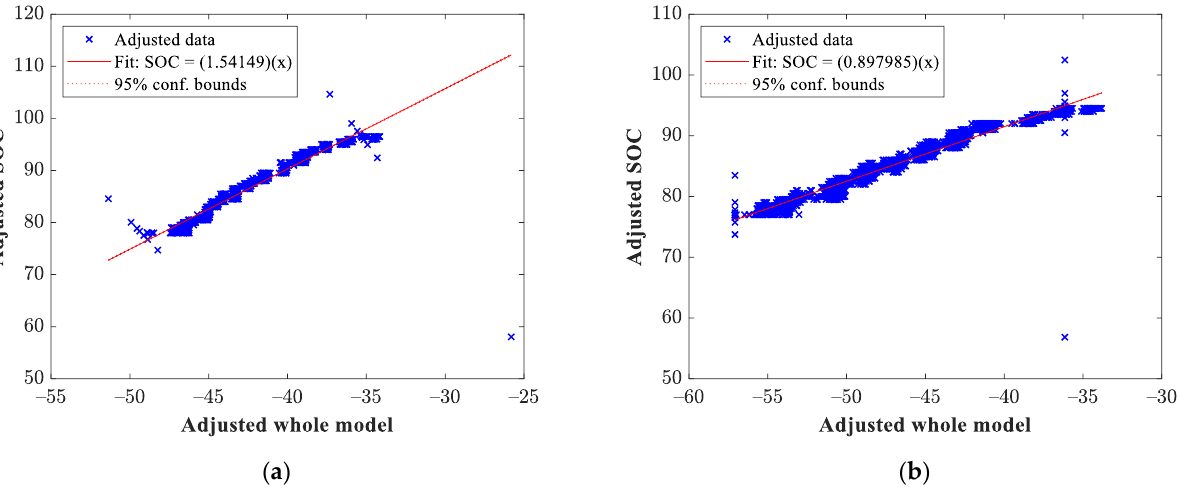
Figure 8. Estimated SOC obtained in the test using the third transmission shift results: ( a ) test 5 (test with the lowest RMSE value) and ( b ) test 1 (test with the highest RMSE